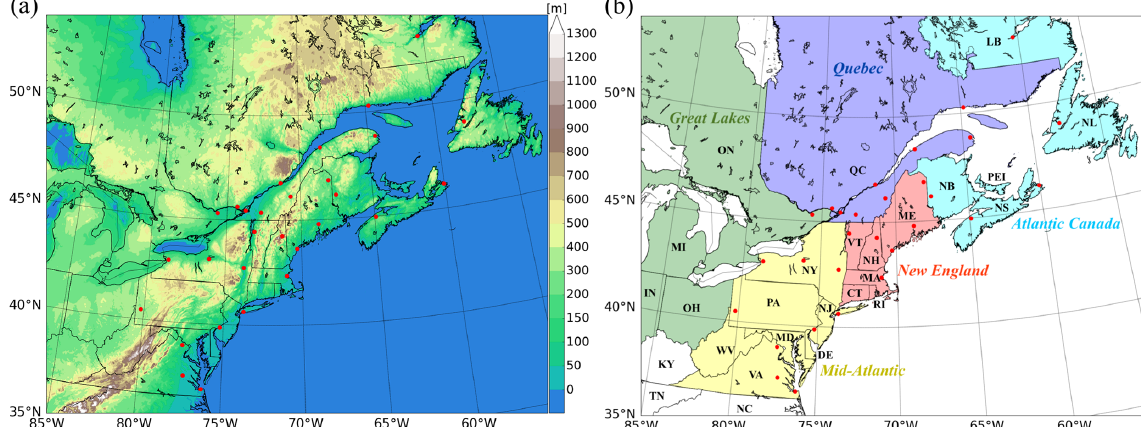
Figure 2. (a) Map of the domain of interest with elevation included. The elevation data shown are ETOPO1 1 Arc-Minute Global Relief (retrieved from https://www.ngdc.noaa.gov/mgg/global/, last access: 24 November 2020; Amante and Eakins, 2009). Red dots represent the locations of the weather stations used in the study as data validation. (b) Map of the domain of interest separated by main geographical regions, with the abbreviations of Canadian provinces and US states included.